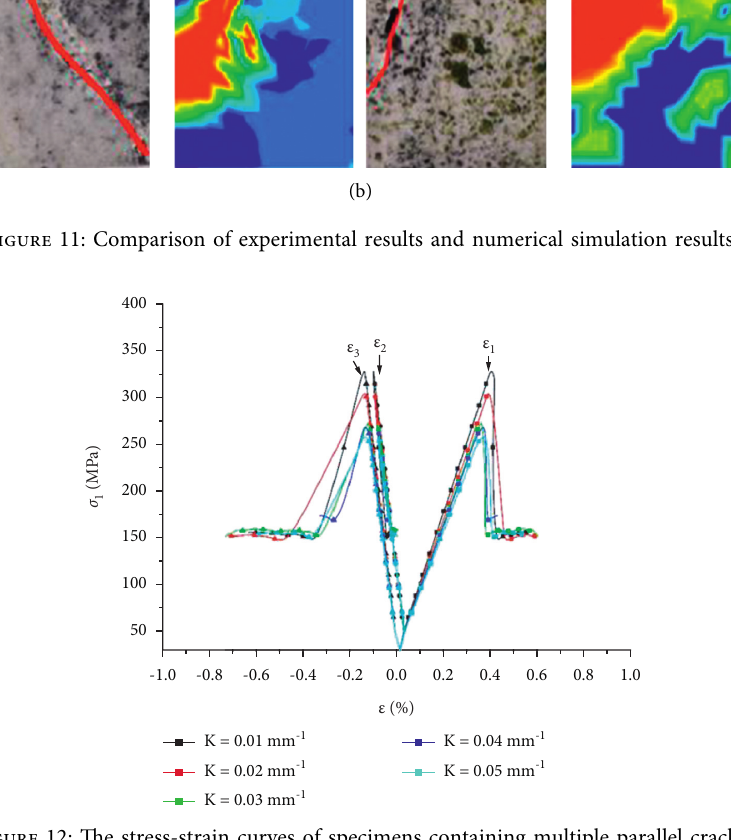
Figure 12: The stress-strain curves of specimens containing multiple parallel